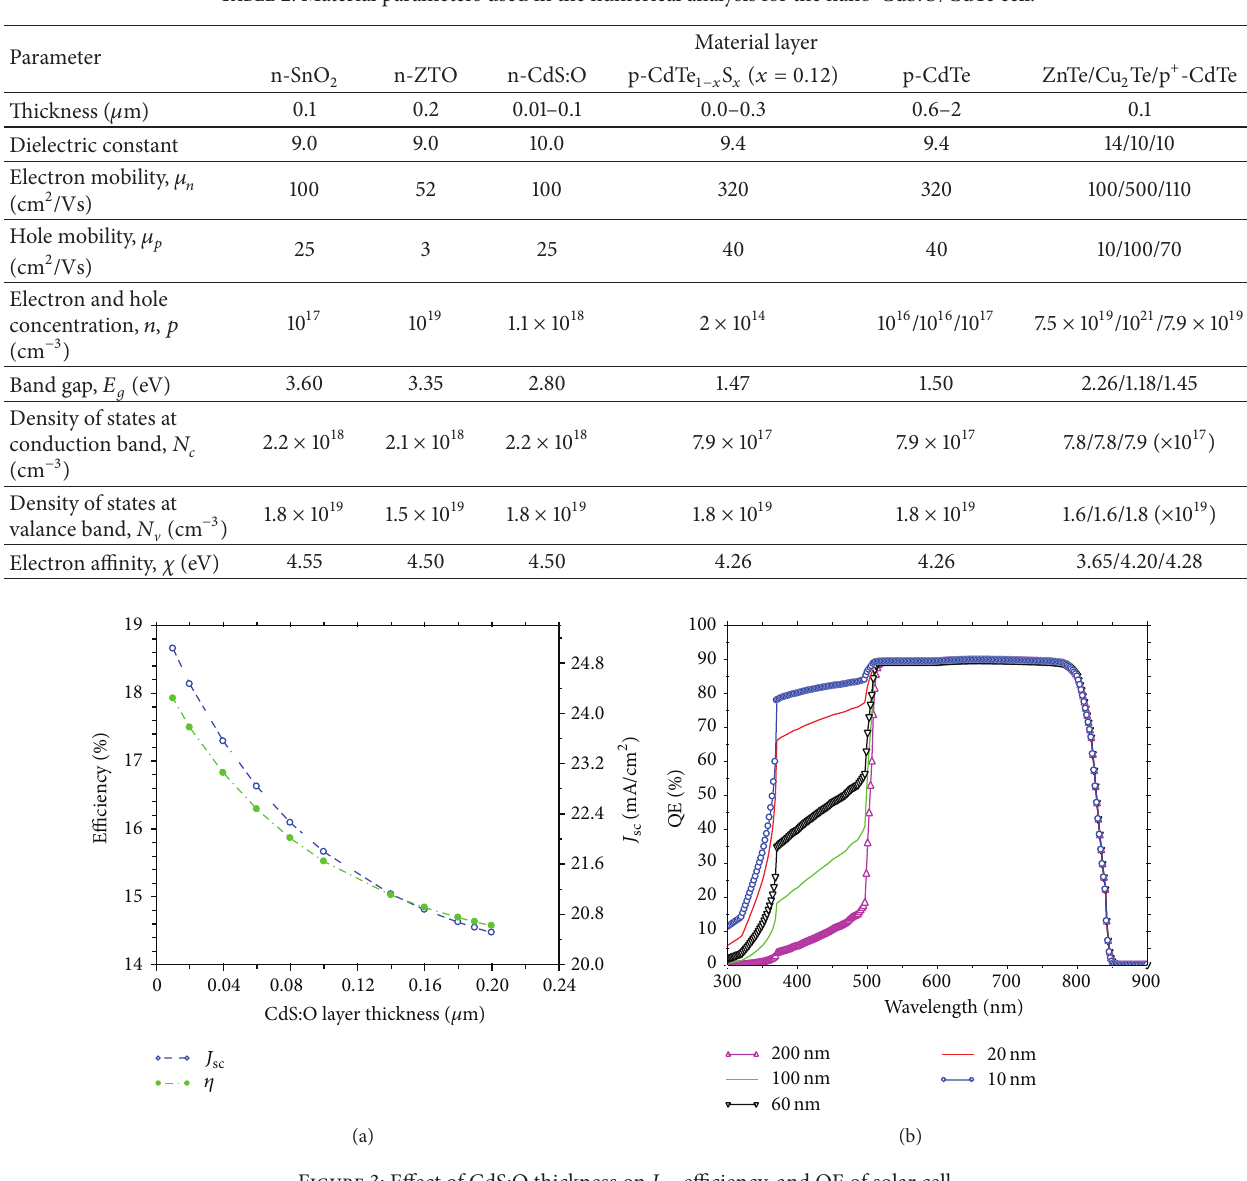
Figure 3: Effect of CdS:O thickness on 𝐽 sc , efficiency, and QE of solar cell.